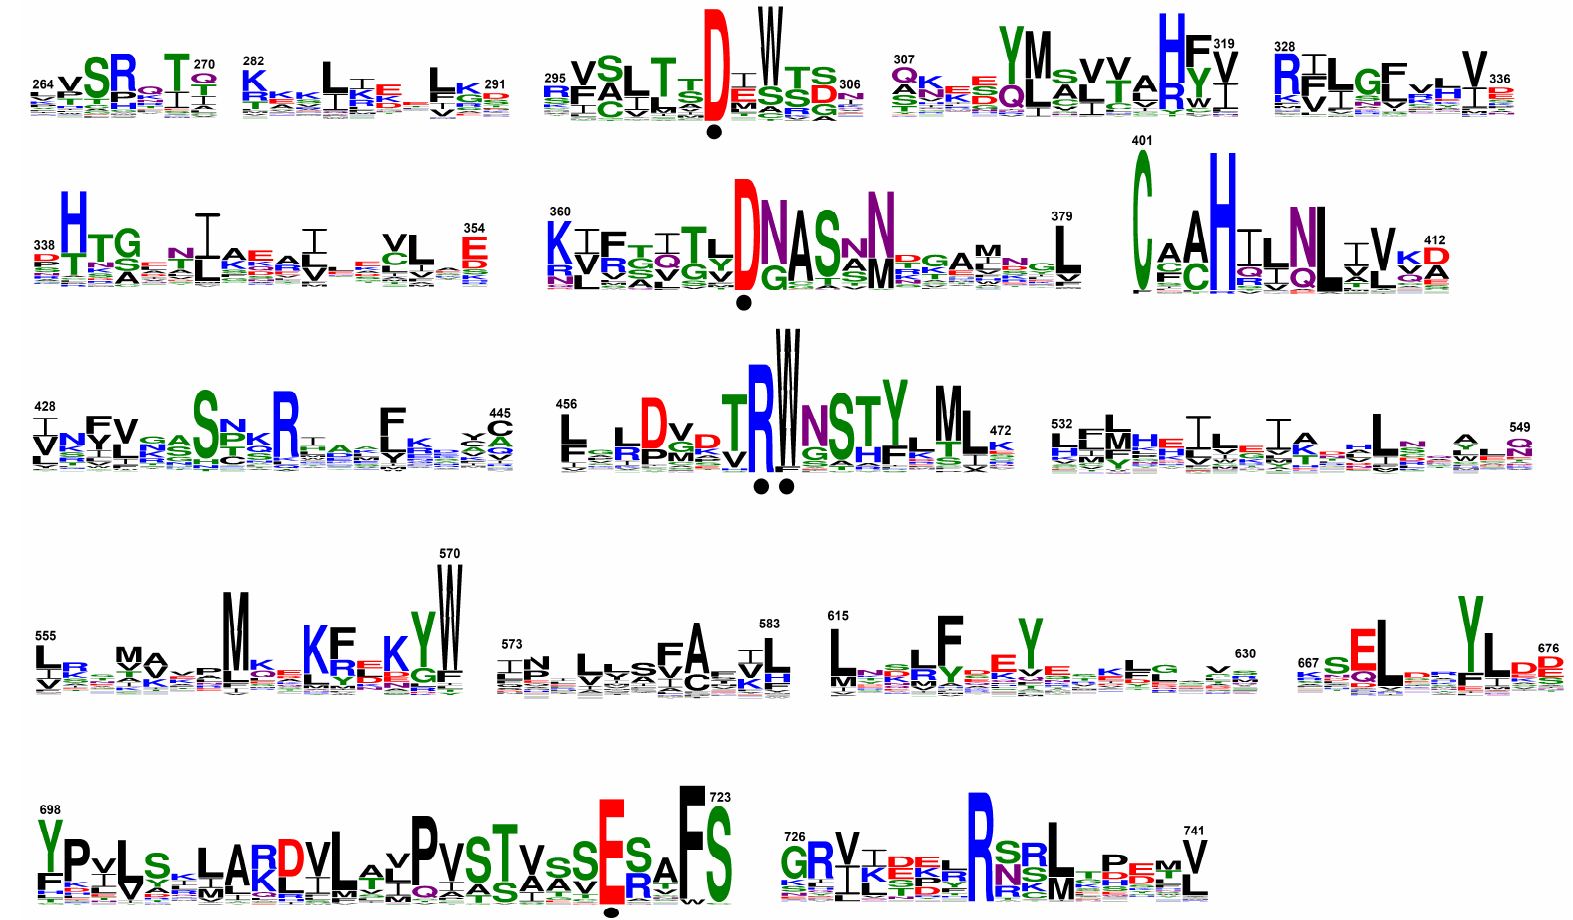
Figure 4. Conserved sequence blocks derived from the plant hAT transposases. The amino acid residues are numbered according to maize Activator (AC). The height of each letter depicts the frequency of the corresponding residues at that position, with the most frequent being on the top. The invariant amino acids essential for the activity of hAT transposases are indicated by dots.